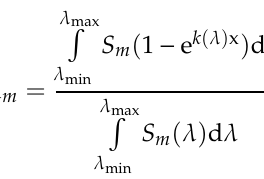
Figure 8. Optical transmittance of nanofluids [49,51]; 2017, 2013, Elsevier.